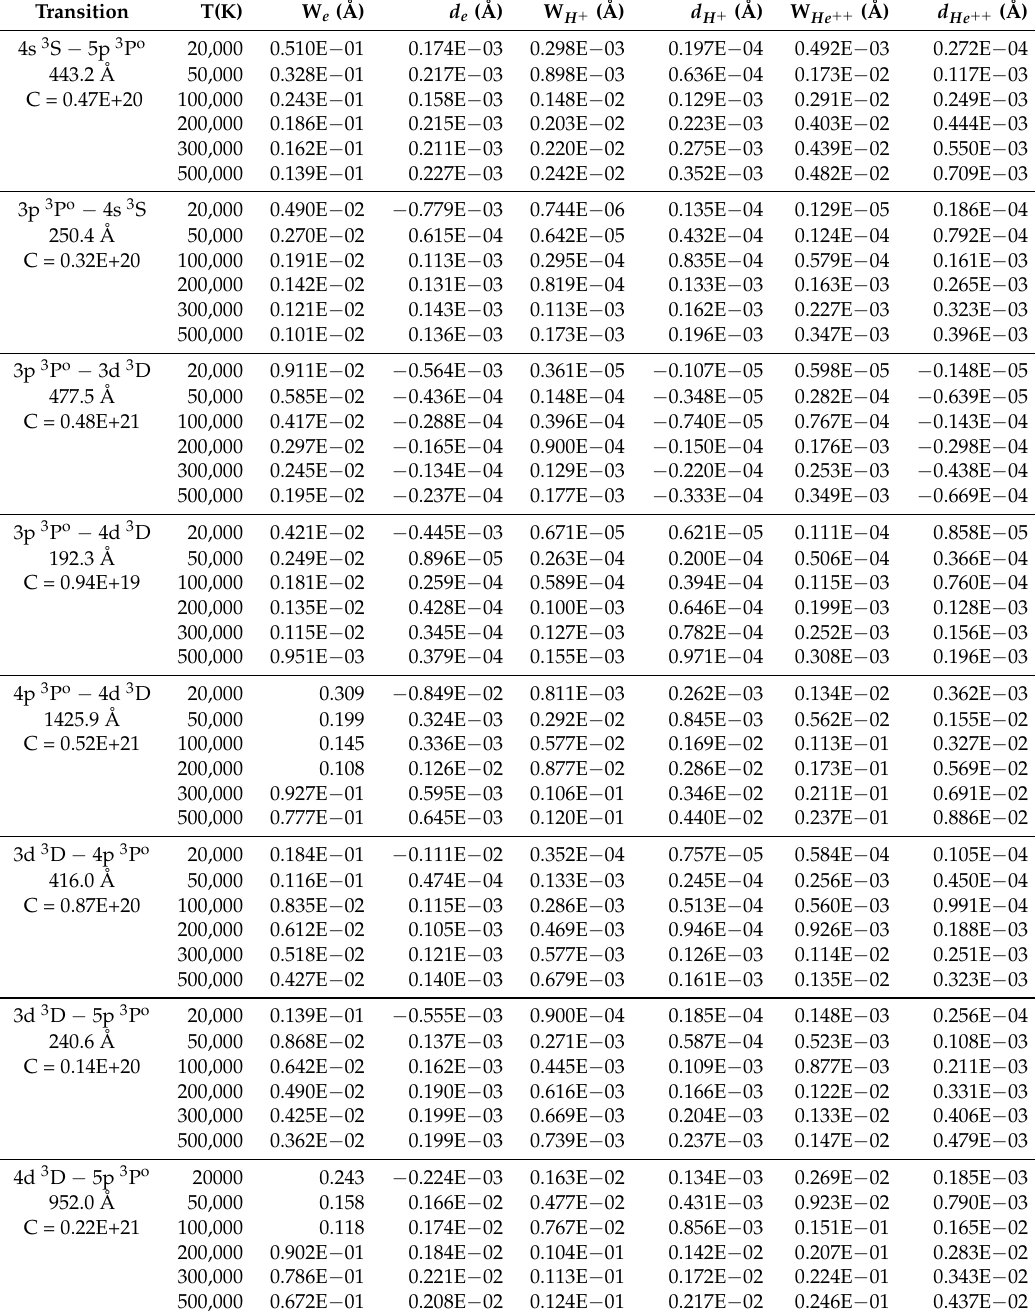
Table 1. Electron-, proton-, and doubly charged helium-impact broadening parameters for Ar VII spectral lines, for a perturber density of 10 18 cm − 3 and temperatures from 20,000 to 500,000 K. The calculated wavelength of the transitions (in Å) and parameter C are also given. When divided by the corresponding Stark width, this parameter gives an estimate for the maximal perturber density for which the line may be treated as isolated. W e : electron-impact full width at half maximum of intensity; d e : electron-impact shift; W p : proton-impact full width at half maximum of intensity; d p : proton-impact shift; W He ++ : doubly charged helium ion-impact full width at half maximum of intensity; d He ++ : doubly charged helium ion-impact